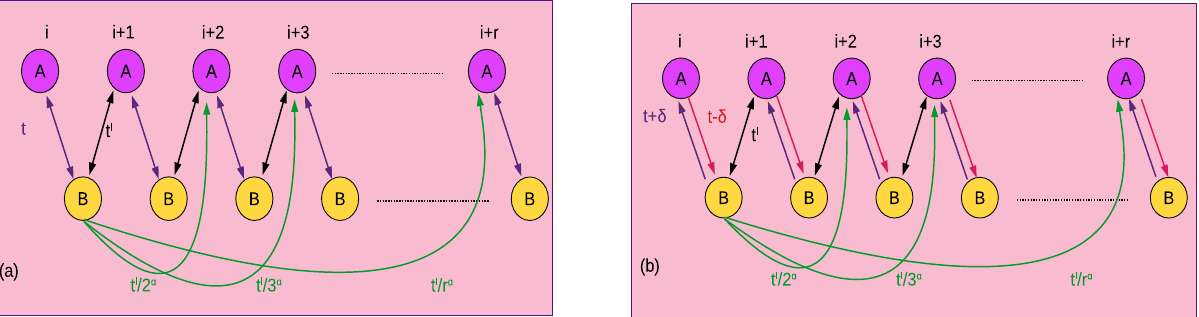
Figure 1. (Color online) Schematic representation of model Hamiltonian in the open boundary condition. ( a ) Hermitian SSH chain ( b ) non-Hermitian SSH chain. The extended-range coupling is introduced through intercell hopping, which decays as power law. The non-Hermiticity is introduced through the imbalance in the intracell